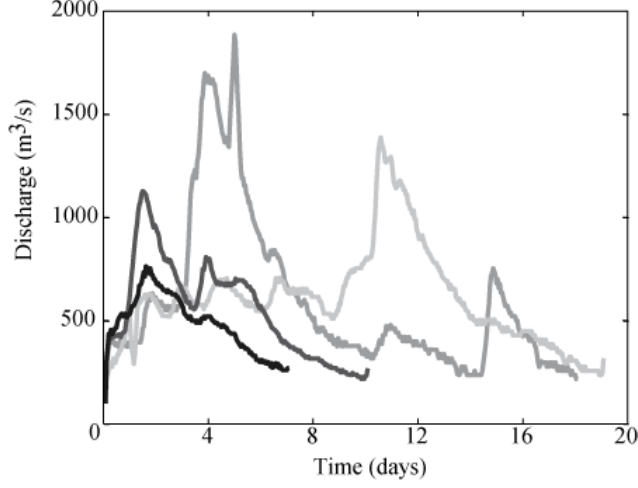
Figure 4. Examples of recorded flood hydrographs at the Belesar